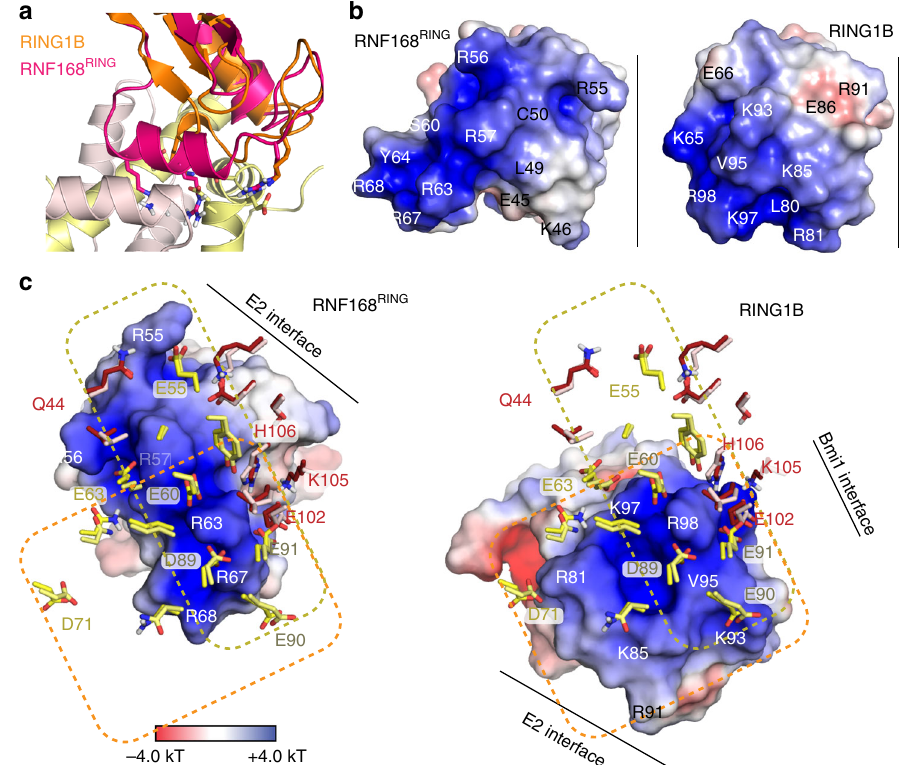
Fig. 6 Comparison of acidic patch binding mode of RNF168 and RING1B. a Superposition of RNF168 RING on the RING1B structure results in severe clashes of the Arg-rich helix with the H2B α C helix. b Molecular surface of the bound states of RNF168 and RING1B RING domains with color coded electrostatic potential, calculated for the solvent accessible surface (color scale shown in panel c ). Both RING domains are shown looking down on their nucleosome binding surface in an aligned orientation. Location of the E2 interface is indicated with a solid line. c Comparison of the acidic patch binding modes of RNF168 RING and RING1B RING , both shown as molecular surface with color coded electrostatic potential, calculated for the solvent accessible surface, and aligned on the nucleosome. The yellow and orange dashed boxes delineate the main interaction sites of RNF168 and RING1B. Selected residues are